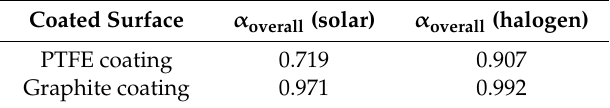
Table 3. Coefficients of solar absorption for various coating types.